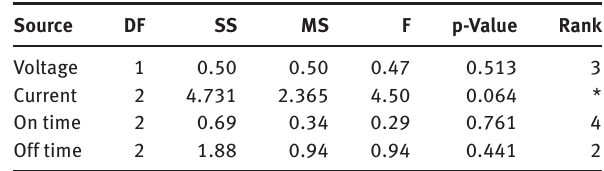
Figure 3: Effects of the input parameters of EDM on SR in the machining of Al/5%Al Table 9: Analysis of variance for SR in the machining of Al/5%Al MMCs.